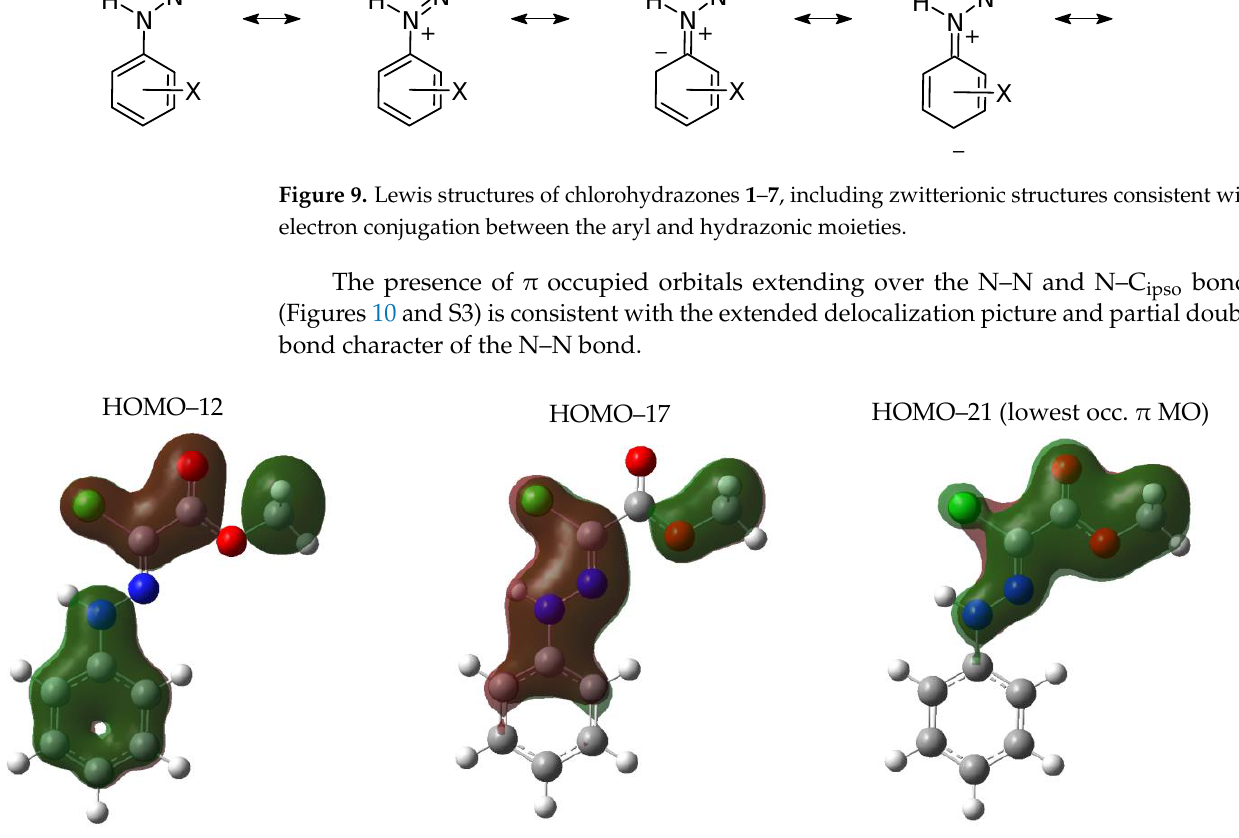
Figure 9. Lewis structures of chlorohydrazones 1 – 7 , including zwitterionic structures consistent with